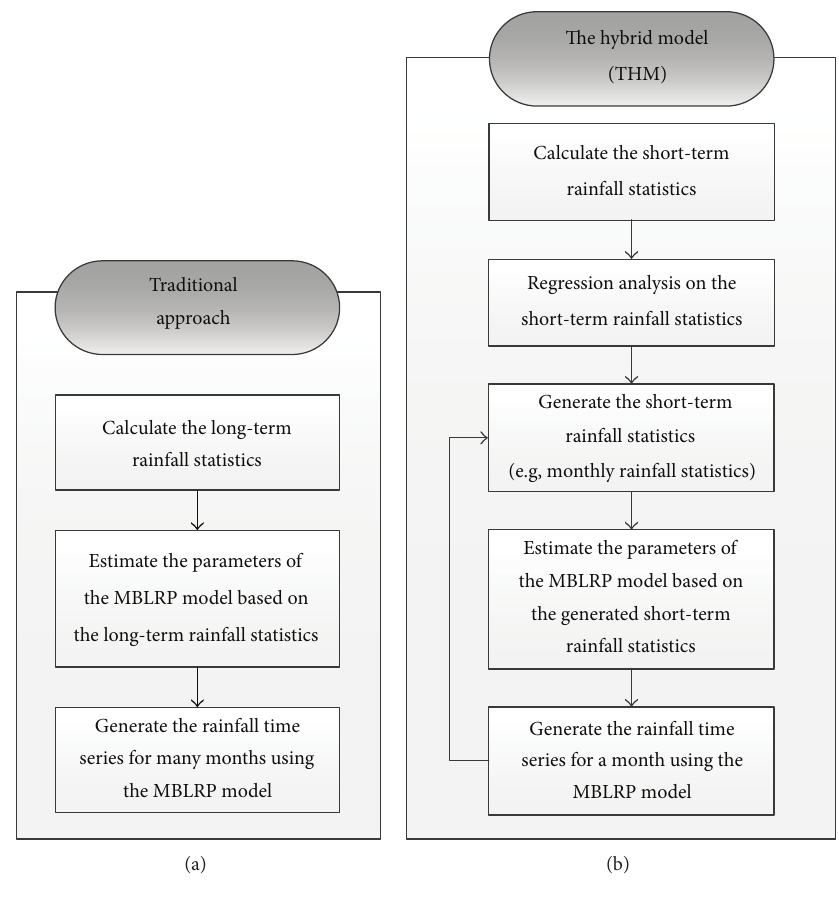
Figure 4: Schematic of the traditional approach of Poisson cluster rainfall modeling (a) and the approach of this study (b).